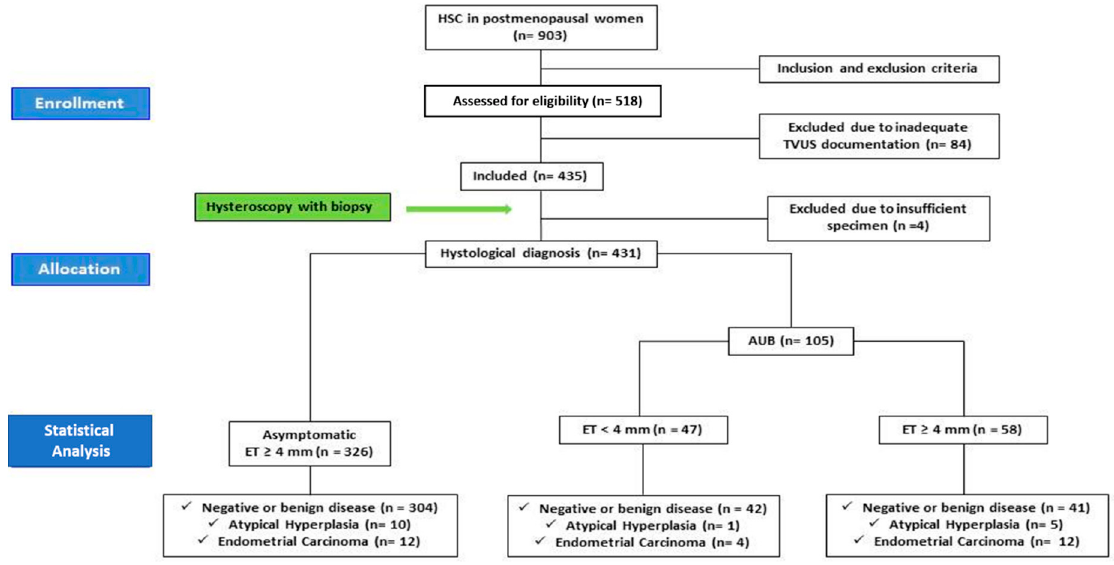
Figure 1. Flow chart of the study. Table 2. General features of patients included in the study.